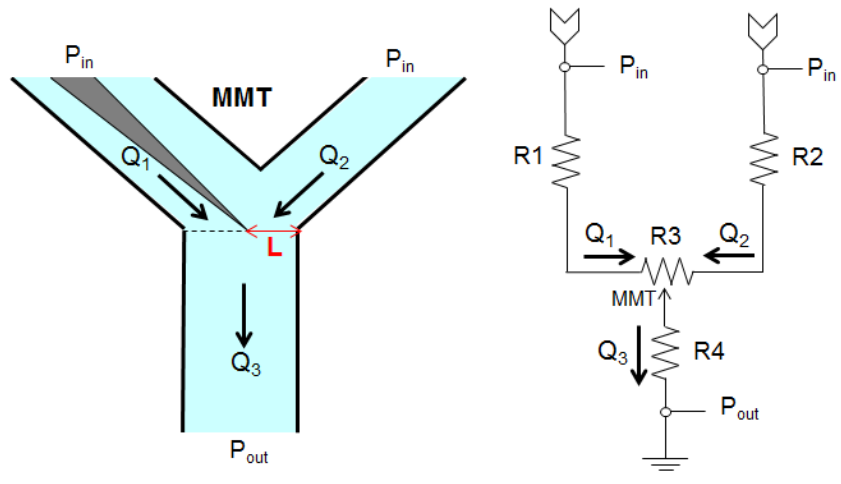
Figure 2. Electric circuit analogy of the enucleation chip.